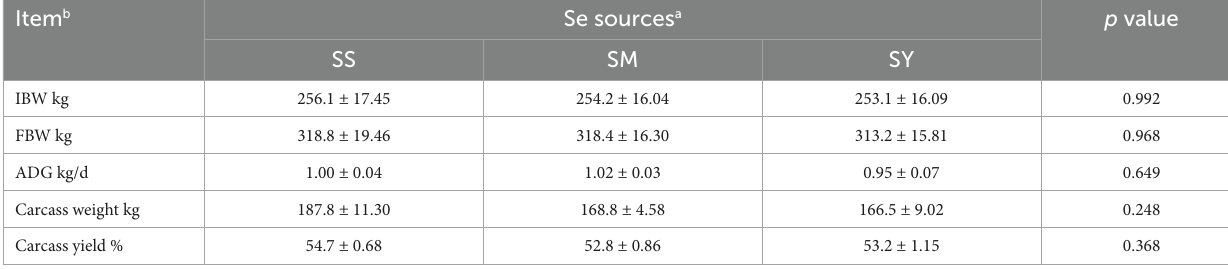
TABLE 2 Effects of different Se sources on the growth performance and carcass characteristics of beef